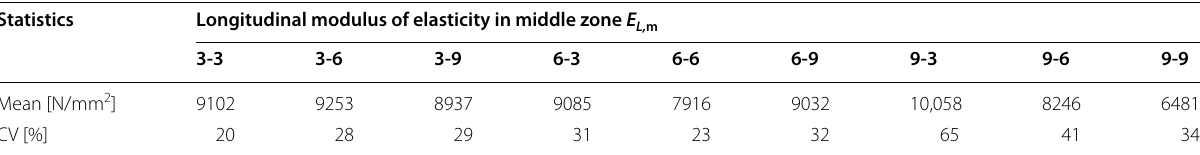
Table 4 Mean values and CV of longitudinal modulus of elasticity in middle zone Statistics